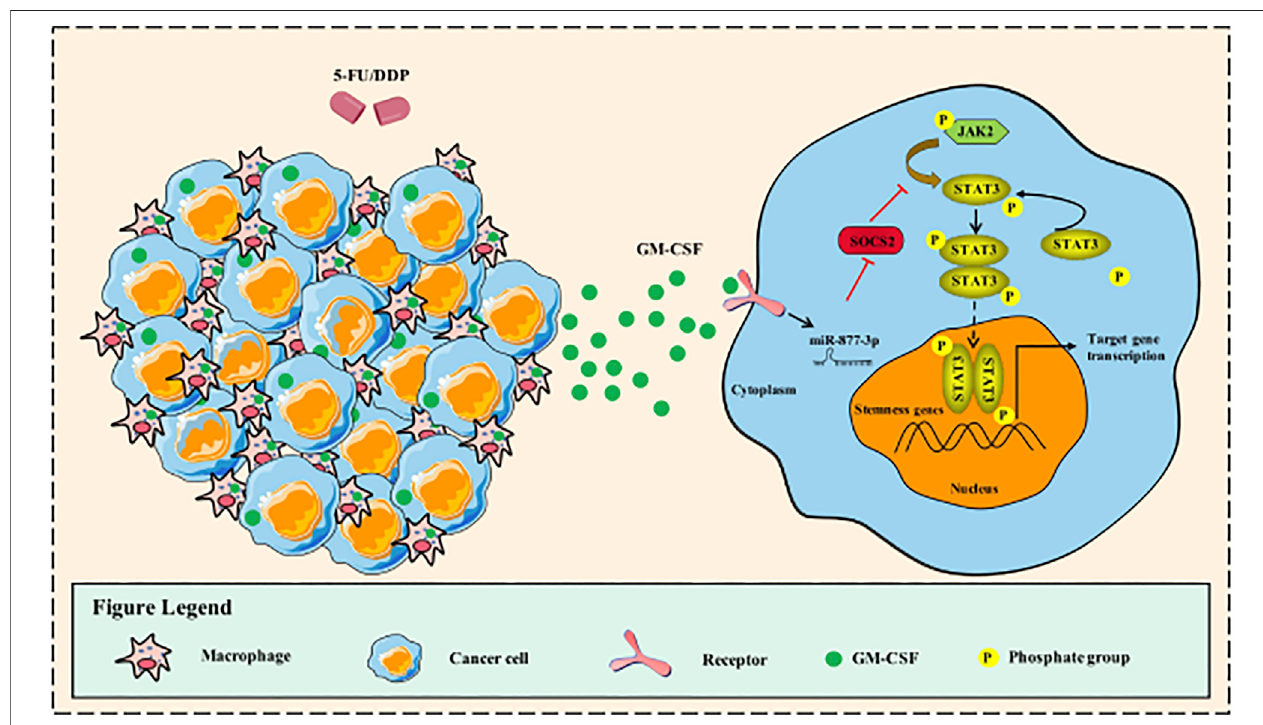
FIGURE 6 | Working Model. Schematic representation of the mechanism through which GM-CSF increased the expression of miR-877-3p in gastric cancer cells, which suppressed the expression of SOCS2 as a target gene. SOCS2 , as a suppressor gene of Jak2/Stat3 signaling, mediated the chemotherapy-induced cancer cell stemness and drug